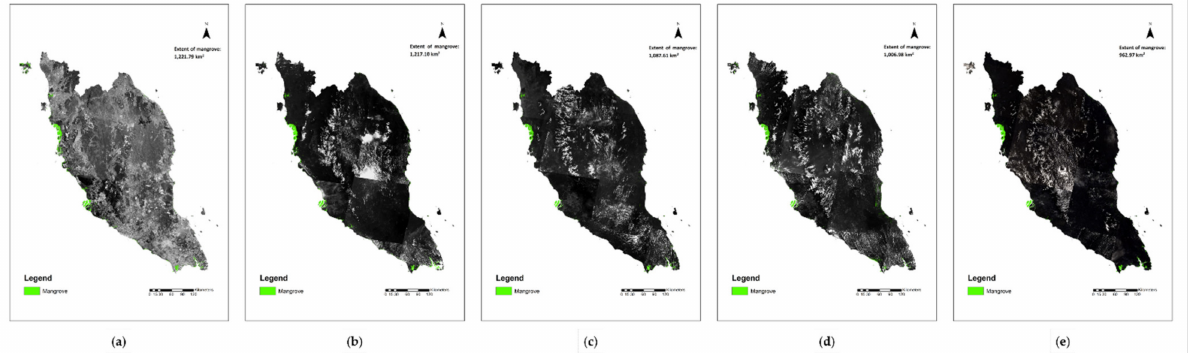
Figure 7. ( a ) Mangrove cover classification for the year 1988 from Landsat images. © Landsat-5 images courtesy of the U.S. Geological Survey; ( b ) Mangrove cover classification for the year 1992 from Landsat images. © Landsat-5 images